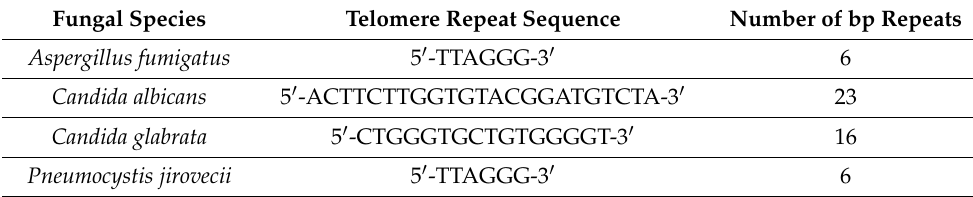
Table 1. Telomere repeat sequences and base pair length for all four opportunistic fungi of this review. Fungal Species Telomere Repeat Sequence Number of bp Repeats Aspergillus fumigatus 5 (cid:48) -TTAGGG-3 (cid:48) Candida albicans Candida glabrata Pneumocystis